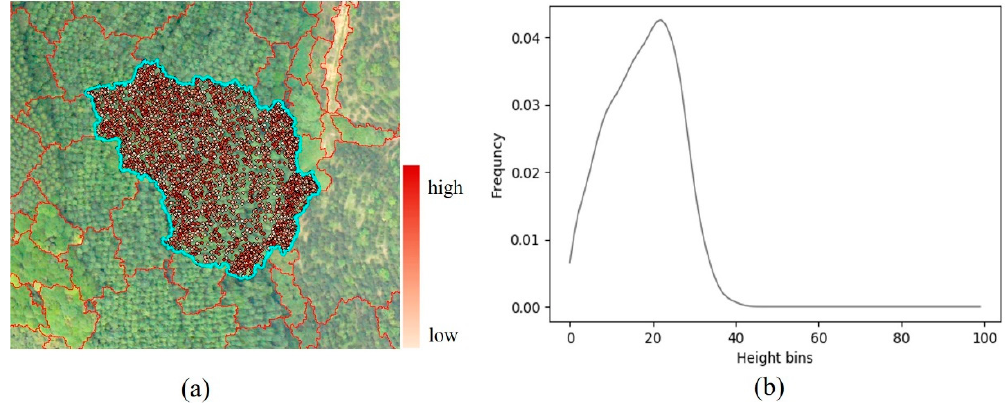
Figure 7. The profile curve in the vertical direction with different characteristics of a tree’s spatial structure.